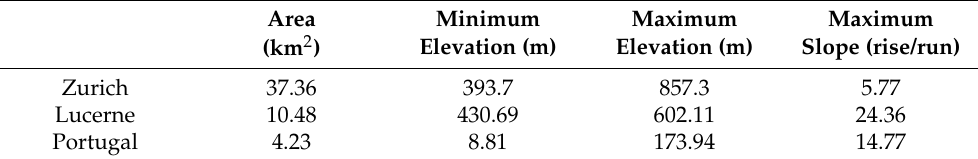
Table 1. Summary of the catchments’ characteristics used in this study.